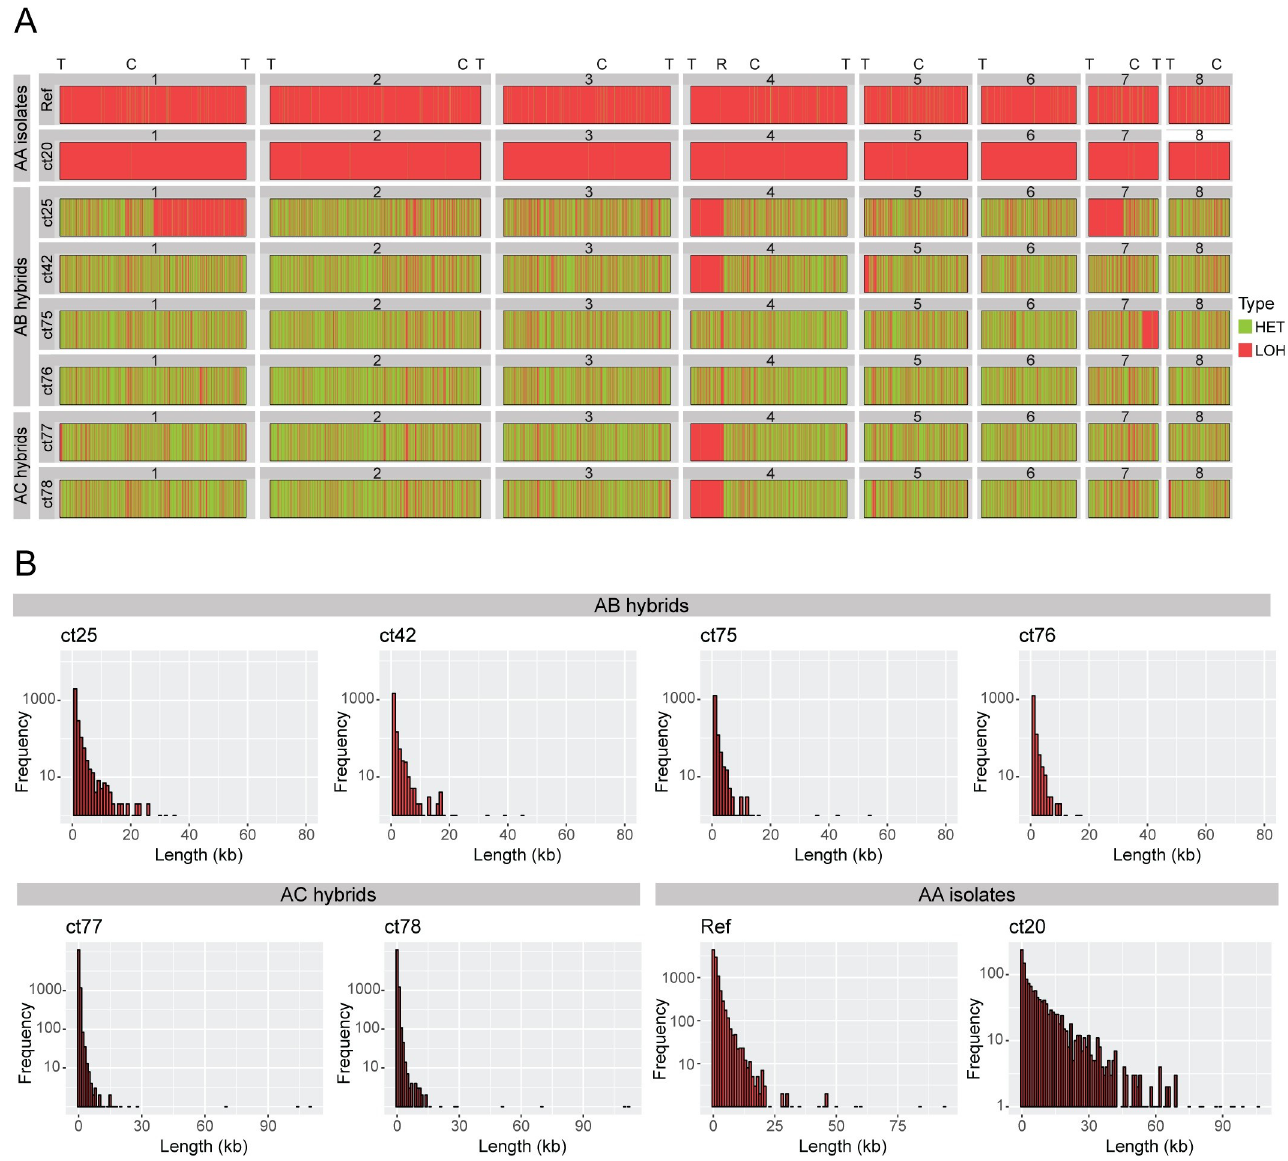
Fig 3. Loss of heterozygosity in C . tropicalis isolates. (A) Hybrid and non-hybrid isolates differ in the extent of LOH across the genome. The eight largest scaffolds in the reference genome are displayed horizontally from left to right and labelled from 1 to 8. LOH blocks are shown in pink and heterozygous (“HET”) blocks are shown in green. Centromere positions are indicated with “C”, telomere positions are indicated with “T” and the rDNA locus is indicated with “R”. Isolates are labelled on the left-hand side. The re-sequenced reference strain C . tropicalis MYA-3404 (labelled as “Ref”) is shown as a representative of the non- hybrid (AA) isolates. The genomes of the AA isolates consist mostly of LOH blocks. The AA isolate C . tropicalis ct20 has undergone extensive LOH, covering > 99% of the genome. In contrast, in the AB/AC isolates, the majority of the genome consists of heterozygous blocks. (B) LOH is limited to short tracts of the genome in hybrid isolates. The histograms show the frequency of LOH blocks of different lengths in the six hybrid isolates and two AA (non-hybrid) isolates the re-sequenced reference strain C . tropicali s MYA-3404 (labelled as “Ref”) and C . tropicalis ct20. Frequency is shown on a log scale on the Y-axis while length in kilobases (kb) is shown on the X-axis, with a bin width of 1000 bp. The average length of LOH blocks in the hybrid isolates ranges from 286–416 bp. A similar pattern is observed in all six hybrid isolates, i.e. a predominance of short LOH blocks, with very few long tracts of LOH. In the non-hybrid isolates (e.g. C . tropicalis MYA-3404), LOH blocks are generally longer. C . tropicalis ct20 has the longest average LOH block length (~10 kb). 25 and 42% of the genome. The average length of LOH blocks in the AB/AC isolates is 330 bp, but can be as long as 112 kb (Fig 3B). Only 1.6% of LOH blocks (equating to 731 LOH blocks or 0.5% of all LOH length in bases) is conserved among all six isolates. There are more shared